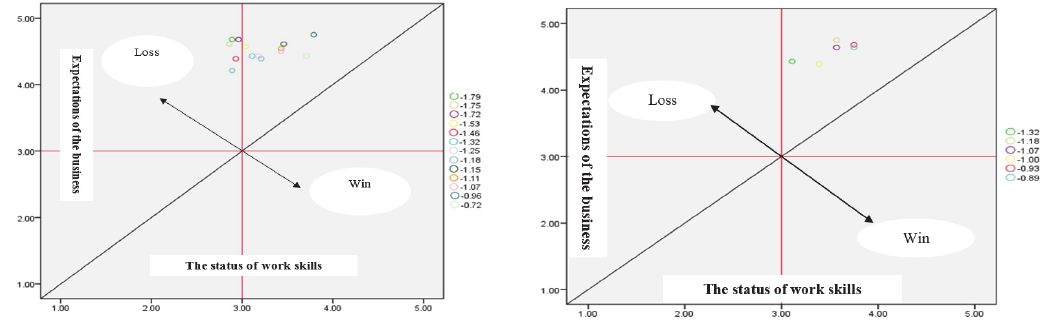
Fig. 4. Business satisfaction on work skills Fig. 5. Business’s satisfaction of working